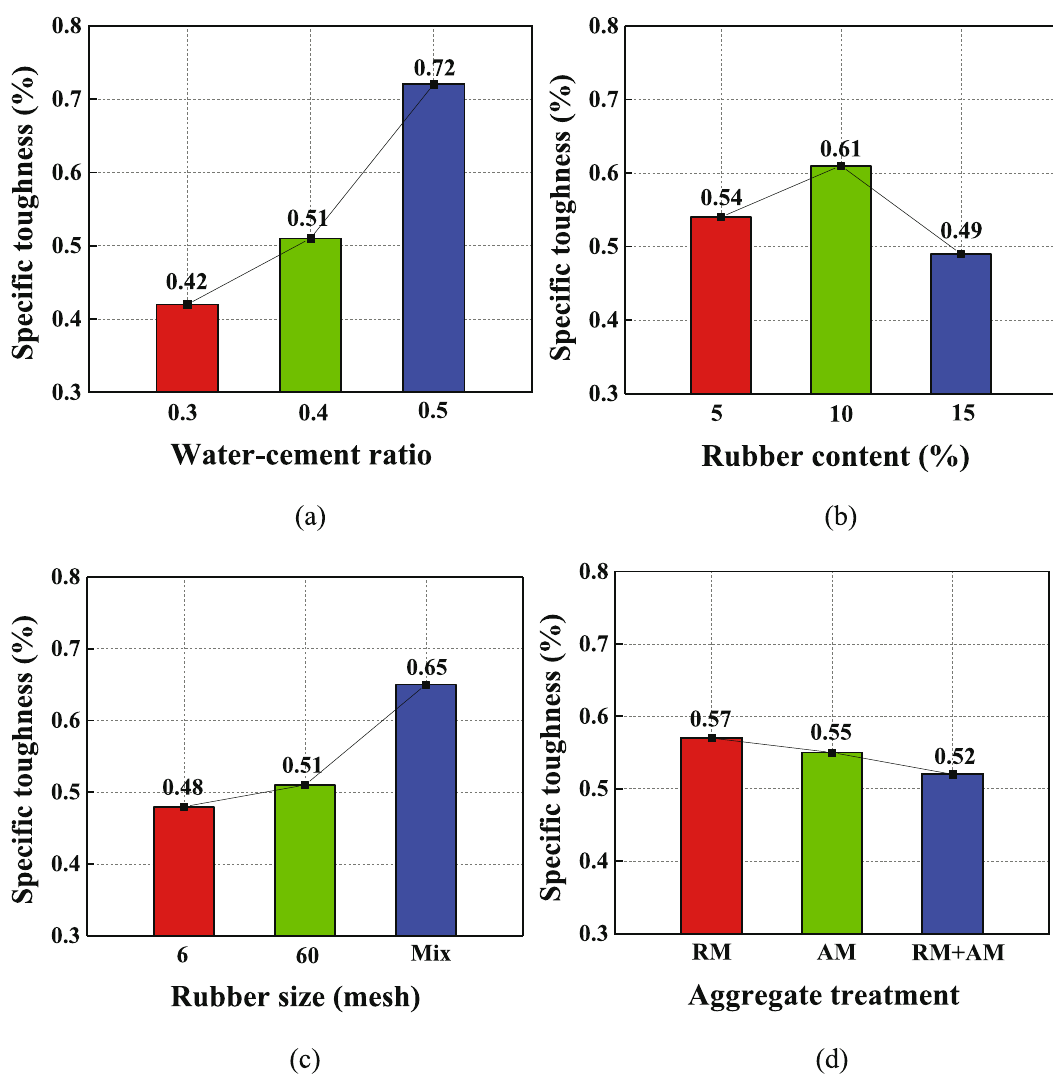
Figure 19: E ff ect of orthogonal factors on speci fi c toughness of RRAC. ( a ) Water – cement ratio, ( b ) rubber content, ( c ) rubber size, and ( d ) aggregate treatment.